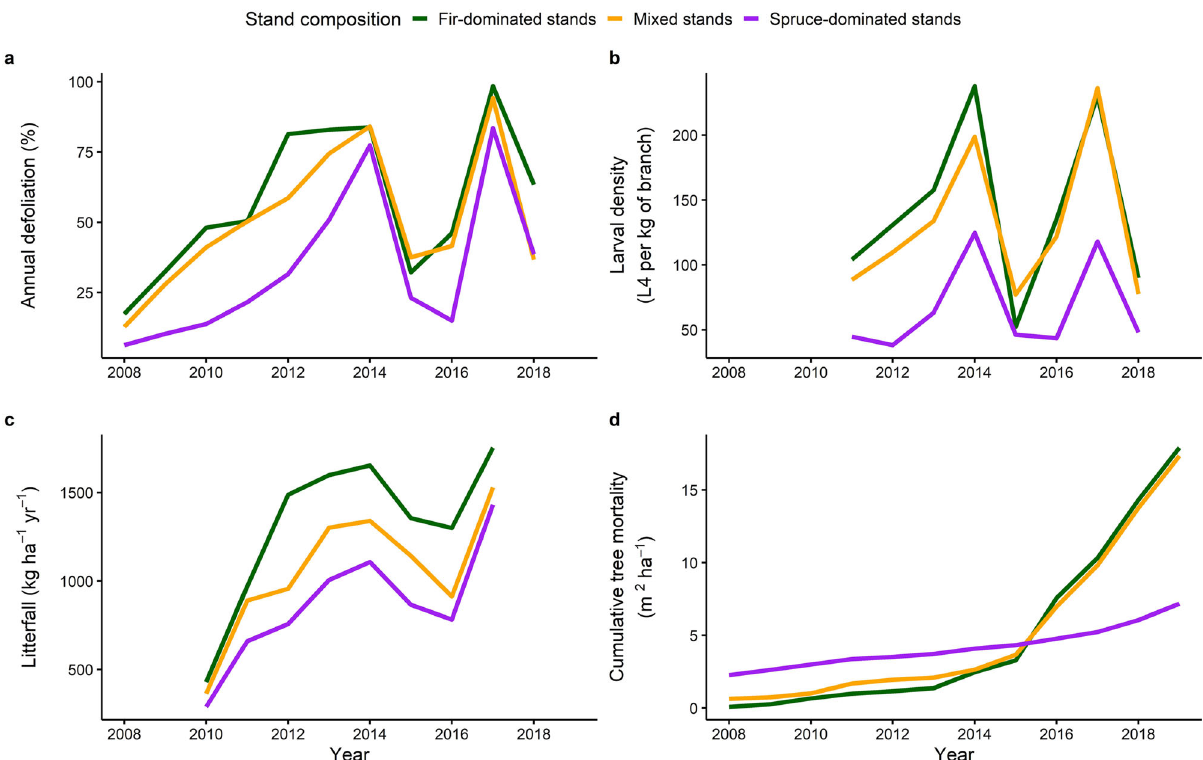
Fig. 1 Overview of SBW outbreak progression among three forest composition types. Annual defoliation ( a ), larval density ( b ), annual litterfall ( c ), and cumulative tree mortality ( d ) with spruce budworm outbreak progression among three forest composition types. Annual defoliation and larval density were averaged from the sampled branches of host trees at the stand level. Litterfall represents the total litterfall (needle and leaf litter, SBW frass) in the 21 traps in each stand, while mortality represents the cumulative annual dead basal area of SBW hosts within each stand. Stand level values were then averaged by forest composition